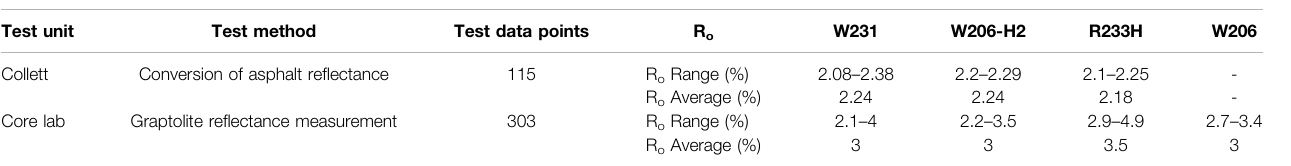
TABLE 1 | OM maturity in the core analysis of sub-member Long 1 1 in the study area. Test